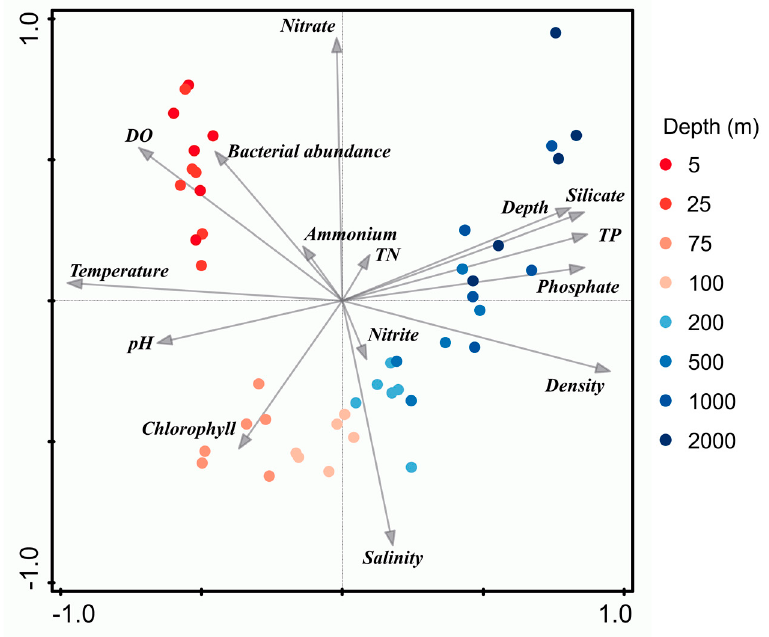
Figure 4. Principal component analysis of measured environmental parameters. Each colored dot represents a sample collected at a specific depth. PC1 and PC2 explained 40.63% and 19.62% of the total variation, respectively.